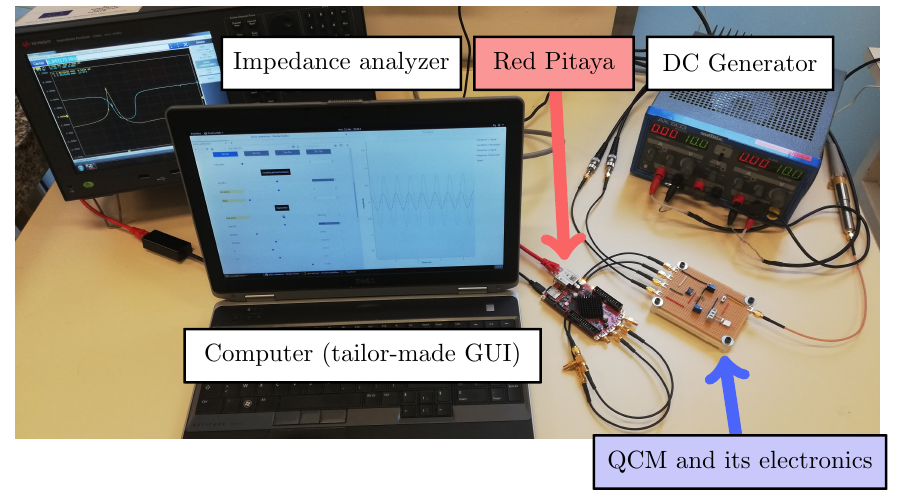
Figure 10. Experimental setup including the piezoelectric resonator, a DC generator, a computer and its GUI, the Red Pitaya, and an impedance analyzer E4990A from Keysight that enables to measure the QCM RtF after each mass deposition for further comparison with ML based methods. The DC generator supplies the operational